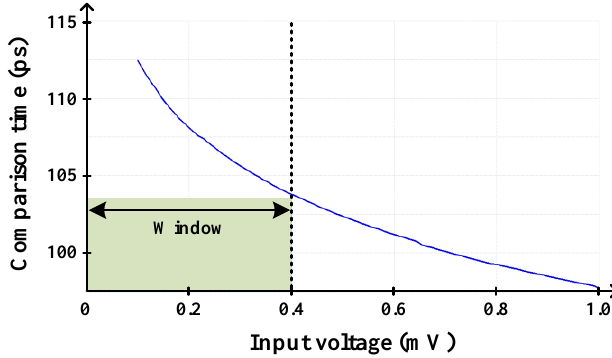
Figure 4. Relationship between the comparison time and input voltage.